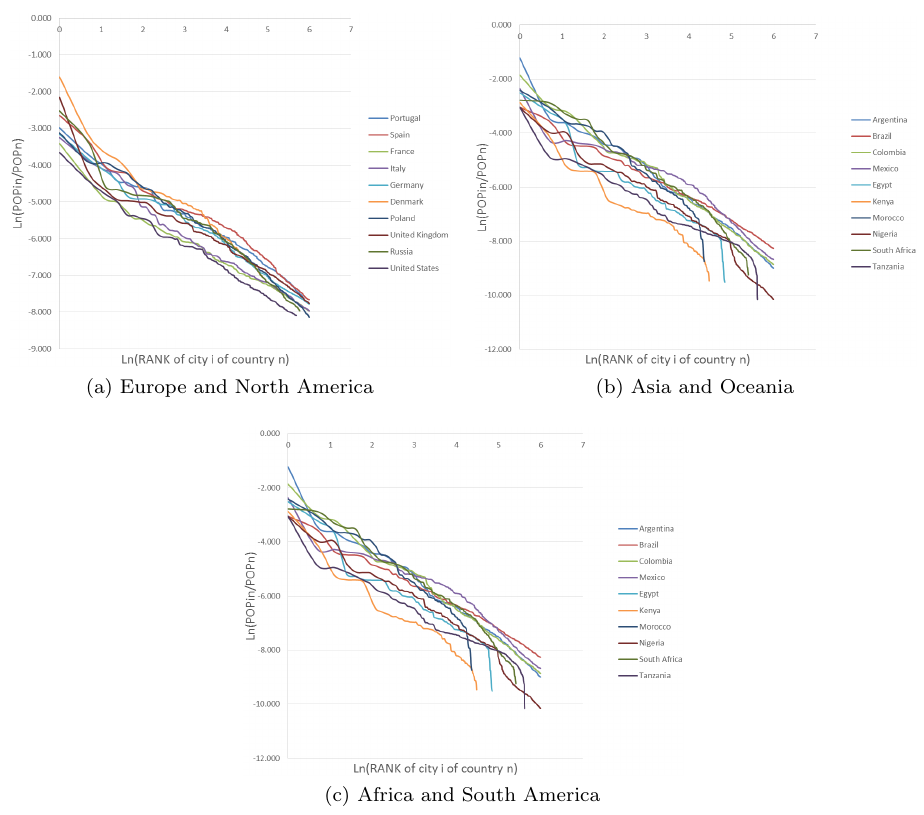
Figure 1: Zipf ’s curve by